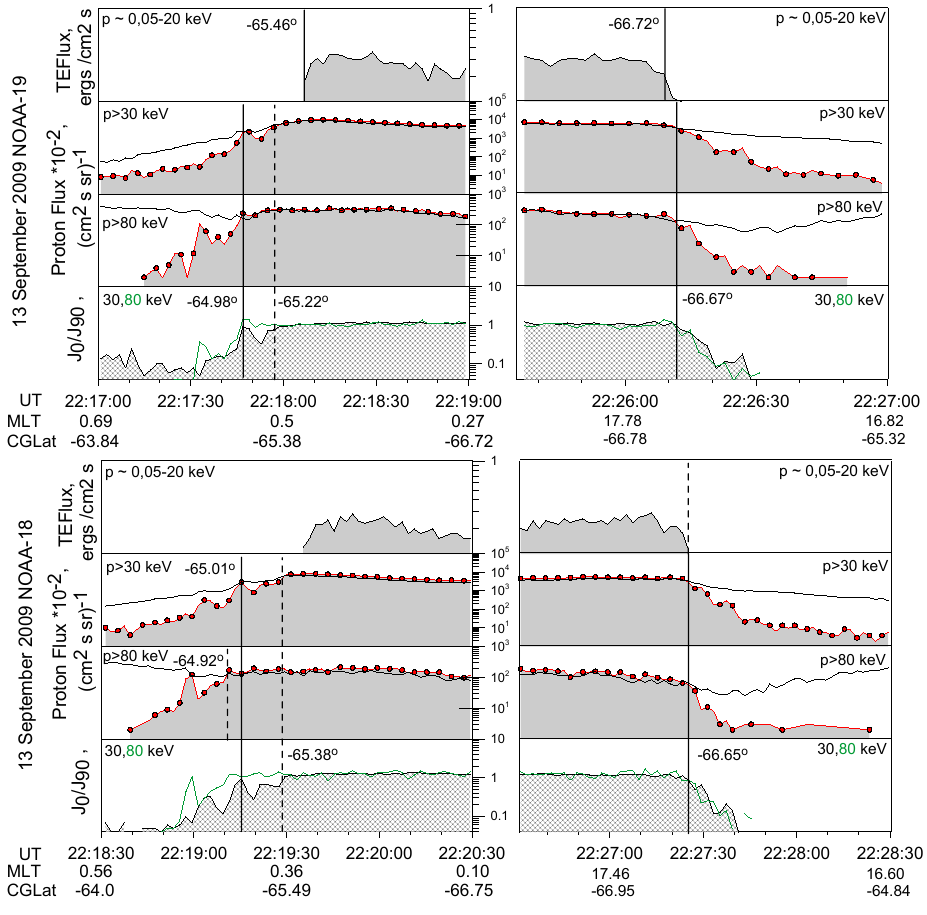
Figure 1. Proton flux variations during oval-skimming passages by the NOAA-19 (top) and NOAA-18 spacecraft (bottom). Spaces below the precipitated flux ( J 0 ) are shaded grey, and trapped flux is shown by the solid line. Dots show the measurements at 2s resolution. The bottom panel for each spacecraft shows the precipitated-to-trapped flux ratio for two energy channels (30keV – black; 80keV – green). Vertical lines mark the sharp flux ratio changes which can be used to identify the isotropy